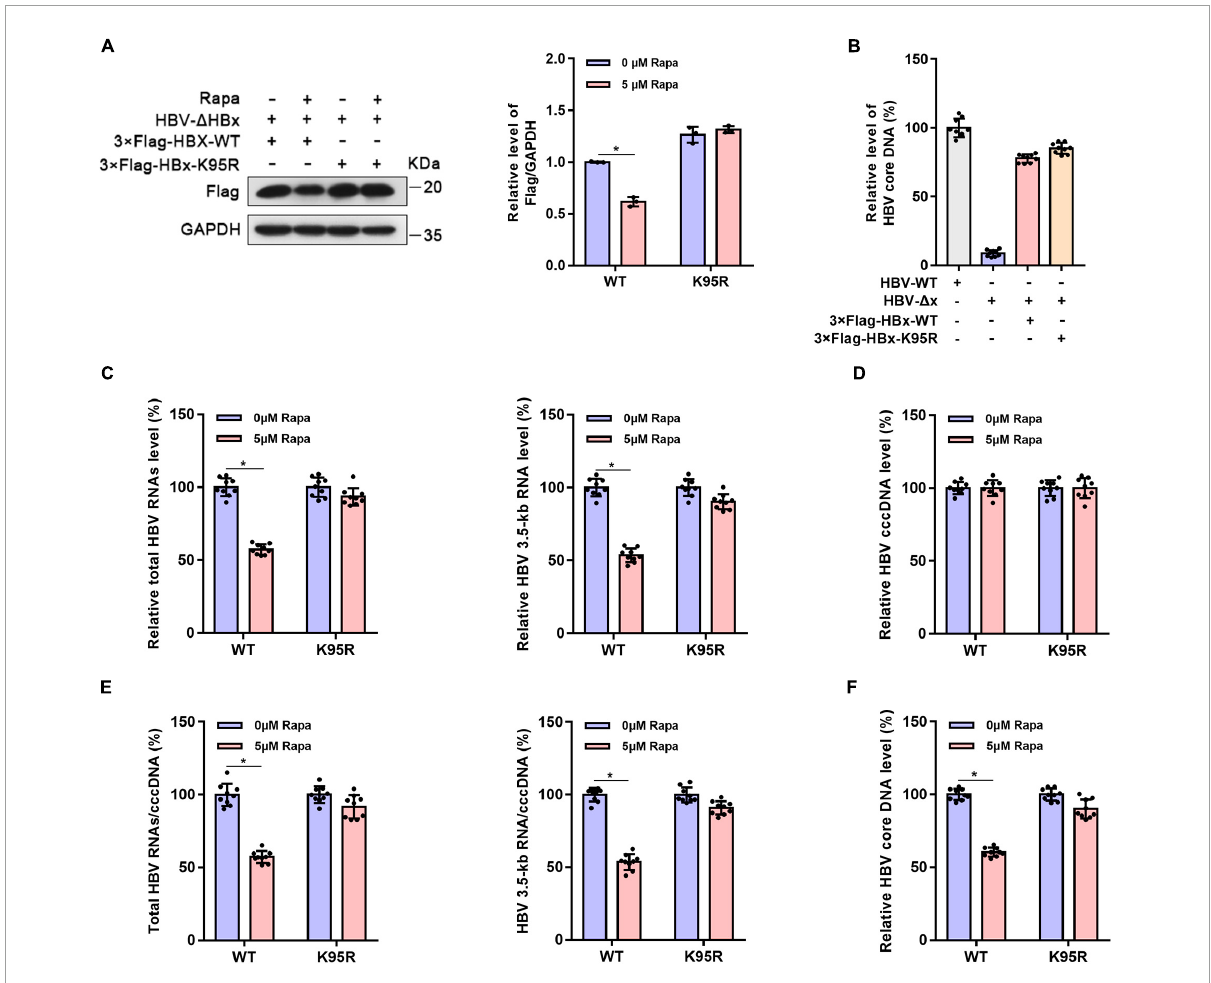
FIGURE4 The inhibitor effect of rapamycin on HBV cccDNA transcription is dependent on ubiquitination. HepG2-NTCP cells were infected with 10 3 genome equivalents/cells of HBV- (cid:49) HBx particles and were then transfected with 3 × Flag-HBx-WT or 3 × Flag-HBx-K95R plasmid. Cells were exposed to rapamycin for 6 days. (A) The protein level of HBx was detected by western blotting analysis, and GAPDH was used as the loading control. (B) The levels of virus production after HBx complementation are represented by the HBV core DNA. The level of HBV core DNA was analyzed by real-time PCR. (C) The levels of total HBV RNAs and 3.5-kb RNA were detected by real-time PCR using specific primers. The β -actin mRNA level was used as an internal control. (D,E) The cccDNA level was analyzed by real-time PCR, and the HBV 3.5-kb RNA/cccDNA and total RNA/cccDNA ratios were calculated. (F) The level of HBV core DNA was analyzed by real-time PCR. The data are presented as the mean ± SD of three independent experiments. * P < 0.05.